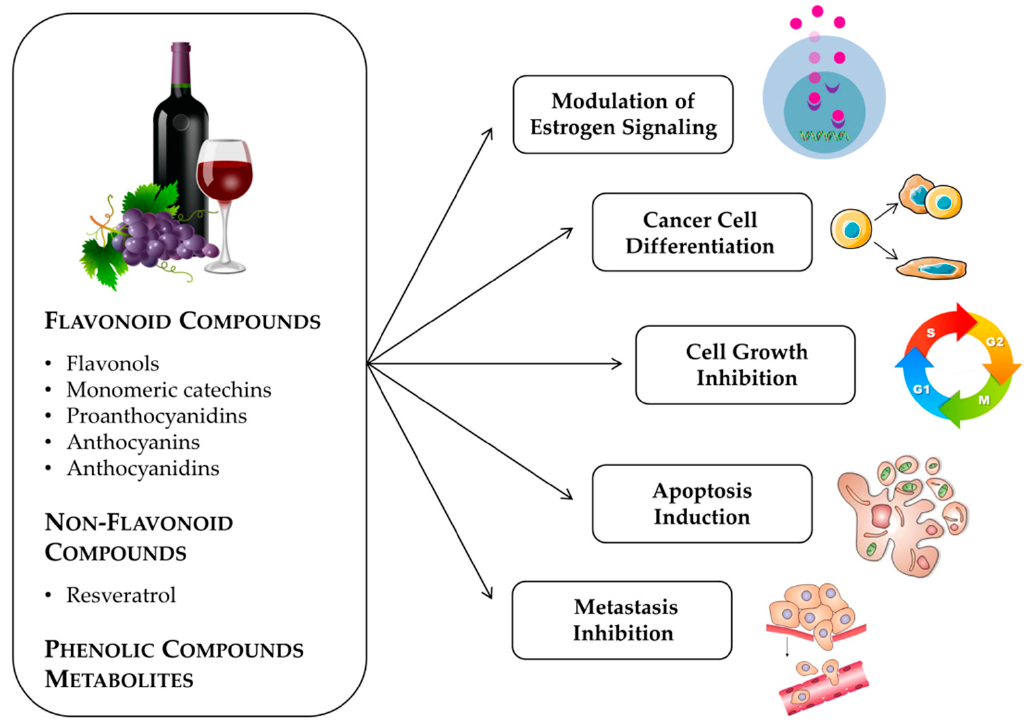
Figure 1. Anticancer activities promoted by phenolic compounds from grapes and red wine and their metabolites.